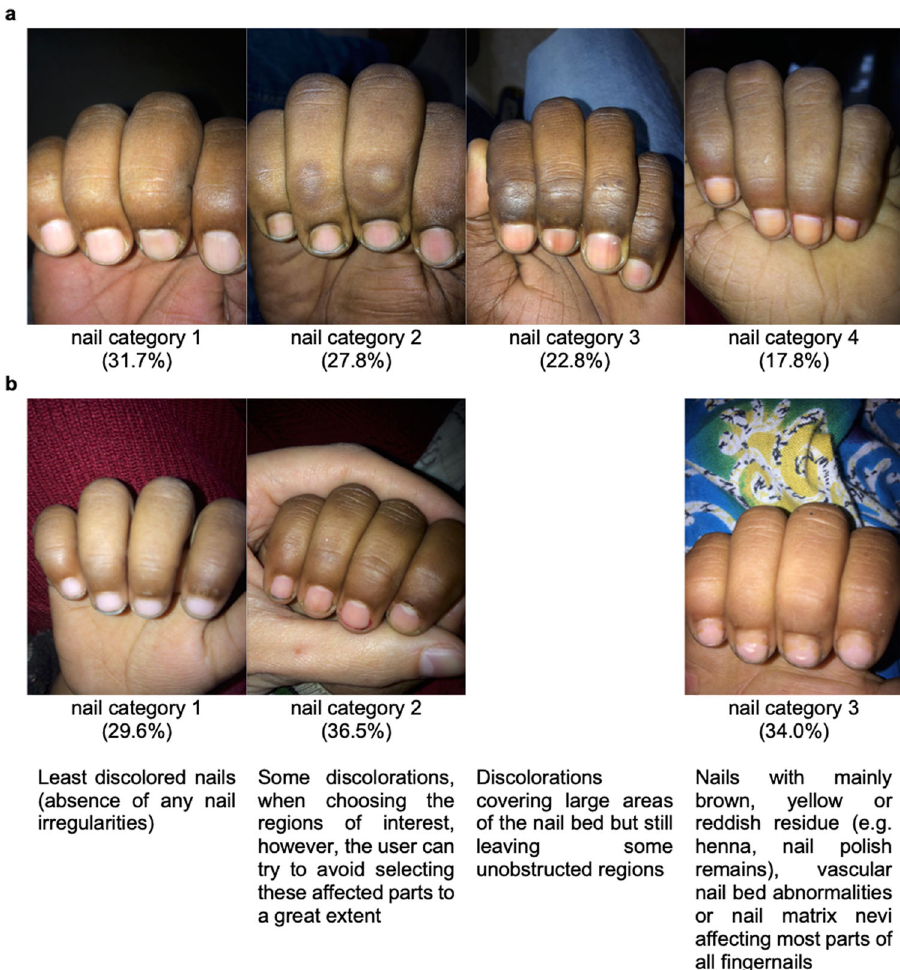
Fig. 1 De fi nition of nail categories. One representative picture of each nail category in a the clinic-based and b the pre-school sample with respective criteria and